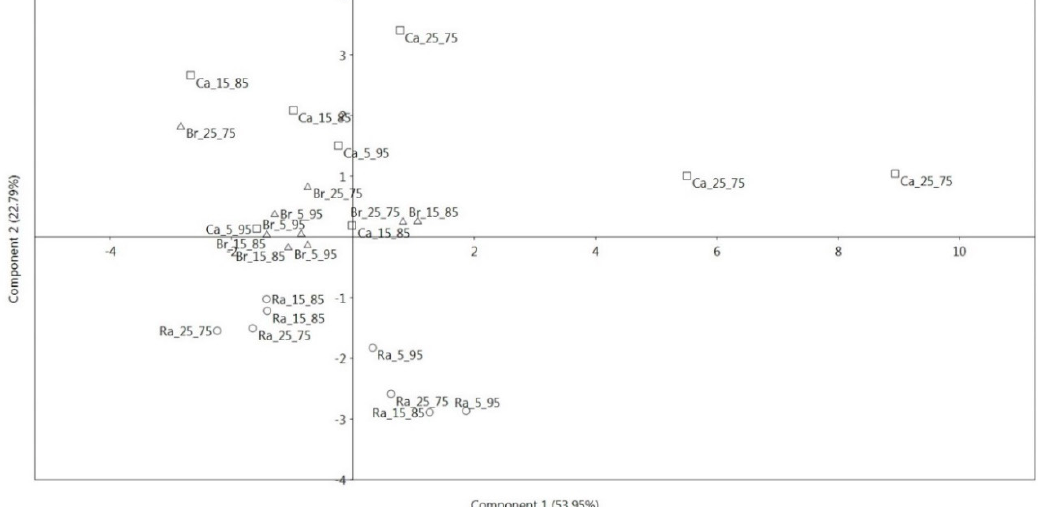
Table 4. Percent of nutritional contribution ( ± standard deviation) of protein, fiber, vitamin A (as β -carotene) and vitamin E (as α -tocopherol) per serving size of Brassica microgreens based on the Dietary Reference Values (DRV).